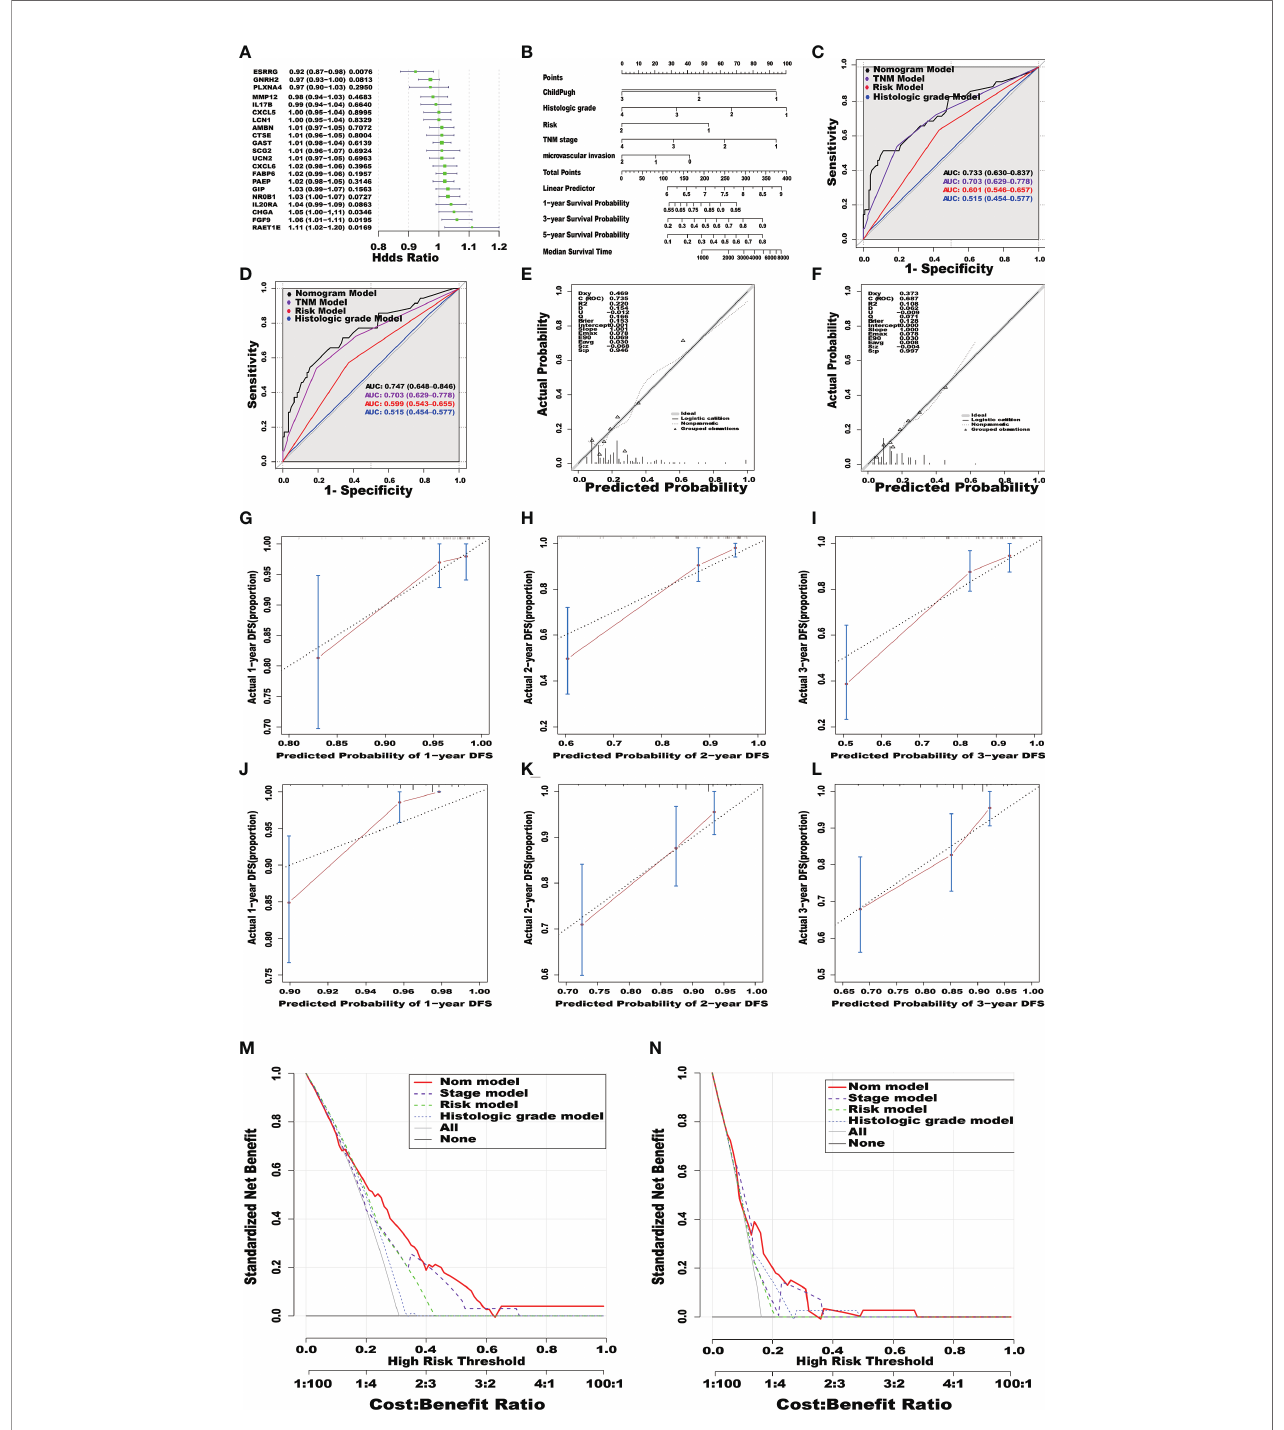
FIGURE 4 | Independent prognostic prediction analysis (A) . The clinical features, including Child Pugh class, histologic grade, TMN stage and microvascular invasion, were combined with Risk Score to construct the nomogram model (B) . The survival predicted ROC curves of four distinct models, namely, Nomogram model, TNM stage model, Risk score model and histologic grade model were compared in TCGA and ICGC database (C, D) . The calibration curve diagrams of the training set (E) and the validation set (F) have good agreement between the predicted probability and the actual probability, both S: p>0.05. The calibration curves of 1,2,3-year survival (G – L) . The dotted line represented the ideal prediction model, and the red solid line represented the observed model in TCGA database (G – I) . The calibration curves of 1,2,3-year survival. The dotted line represented the ideal prediction model, and the red solid line represented the observed model in ICGC database (J – lL) . Decision Curve Analysis model: A clinical decision-making model based on the fi nal multiple risk factors in TCGA and ICGC database (M, N)